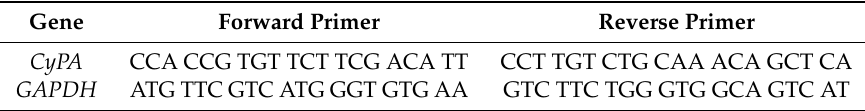
Table 1. Primer sequences (5 (cid:48) -3 (cid:48)